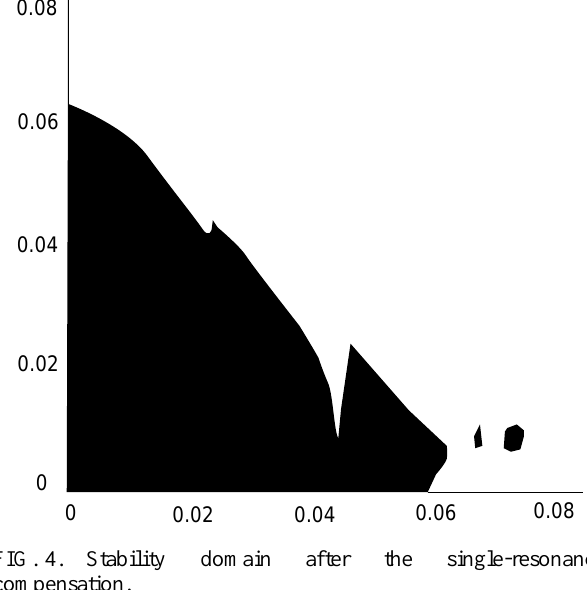
FIG. 2. Stability domain of the uncoupled Hénon map.